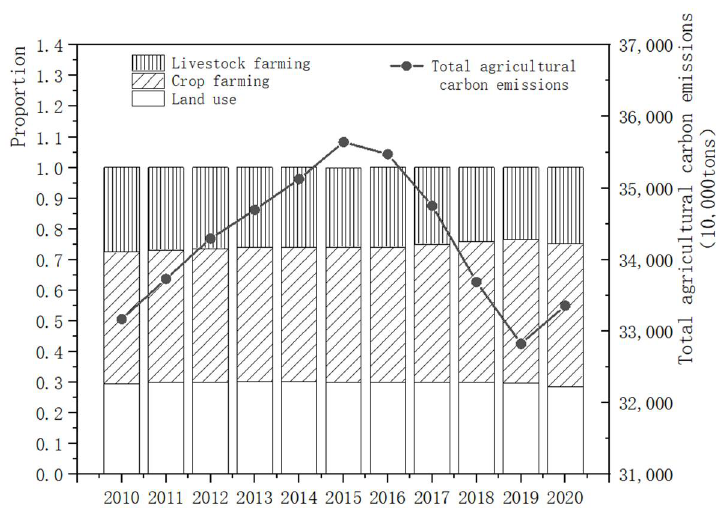
Figure 4. Temporal characteristics of total agricultural carbon emissions and structural propor- tions.